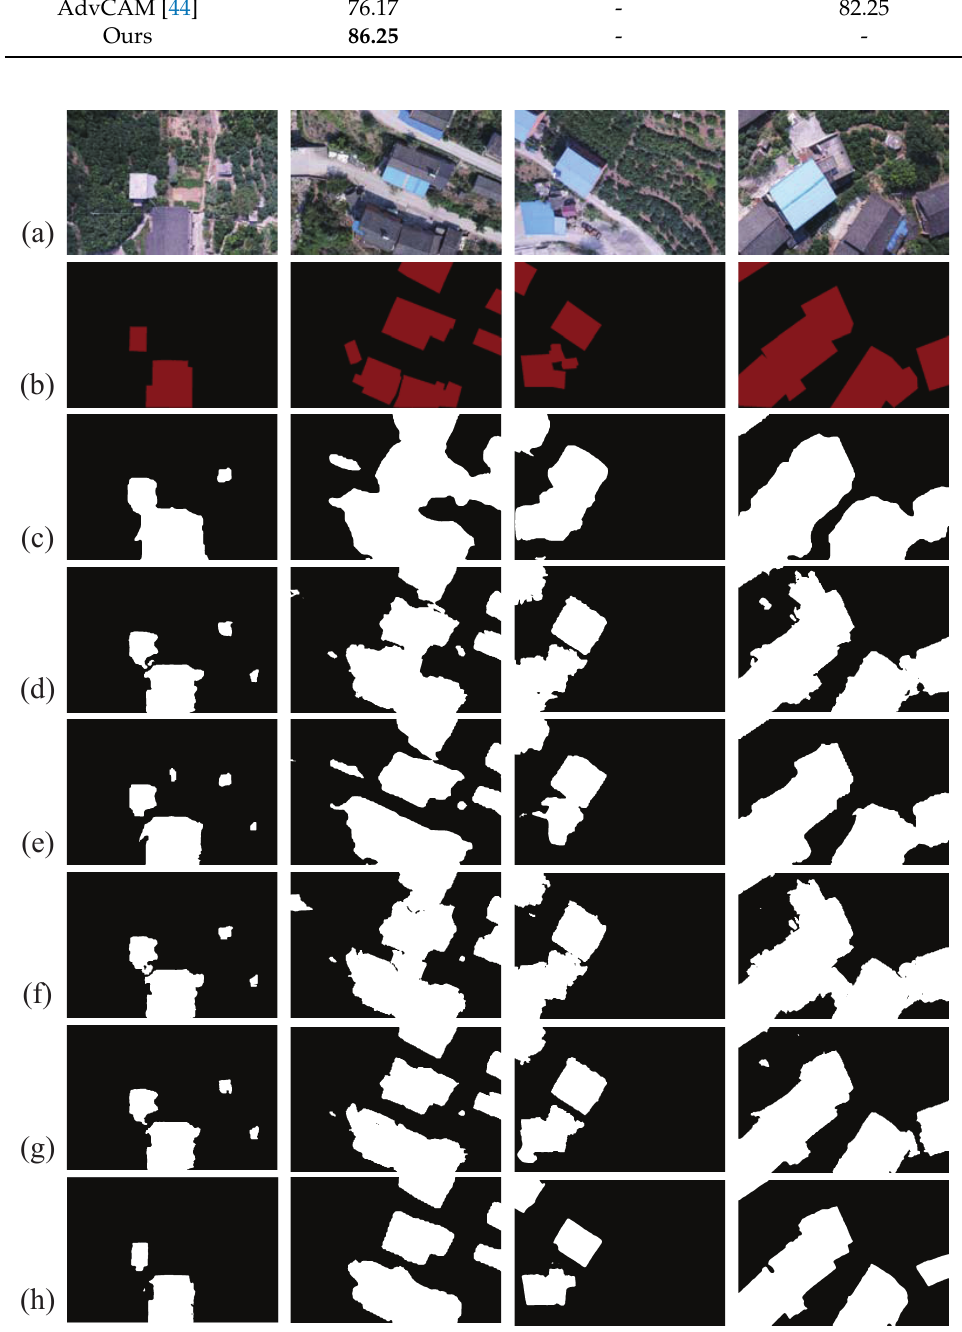
Figure 9. Qualitative comparison of pseudo-labels on Majiagou training set: ( a ) images; ( b ) ground truth; ( c ) AffinityNet; ( d ) IRN; ( e ) SEAM; ( f ) BES; ( g ) AdvCAM; and ( h )